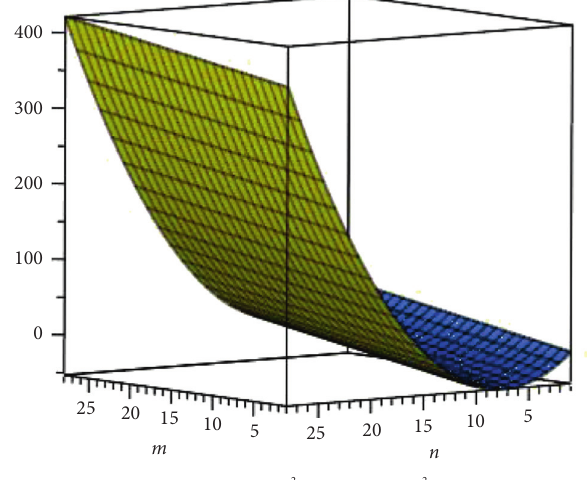
Figure 11: Graph for α � 2 2 4 2 ( nm − n ) + 2 2 2 . 3 2 ( mn − m ) + 24 2 ( mn − m ) + 6 m ( 4 m − 6 ) 2 + 24 2 m ≤ R